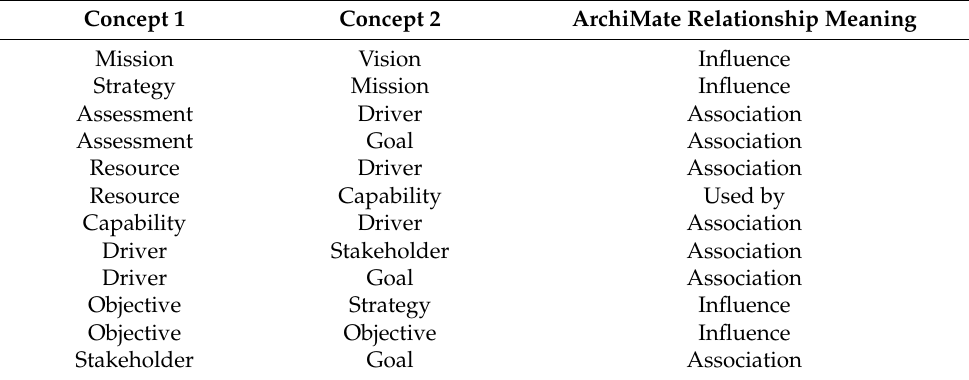
Table 2. Relationships between